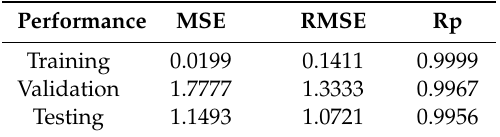
Table 14. Performance of the ANN model for the wet season.